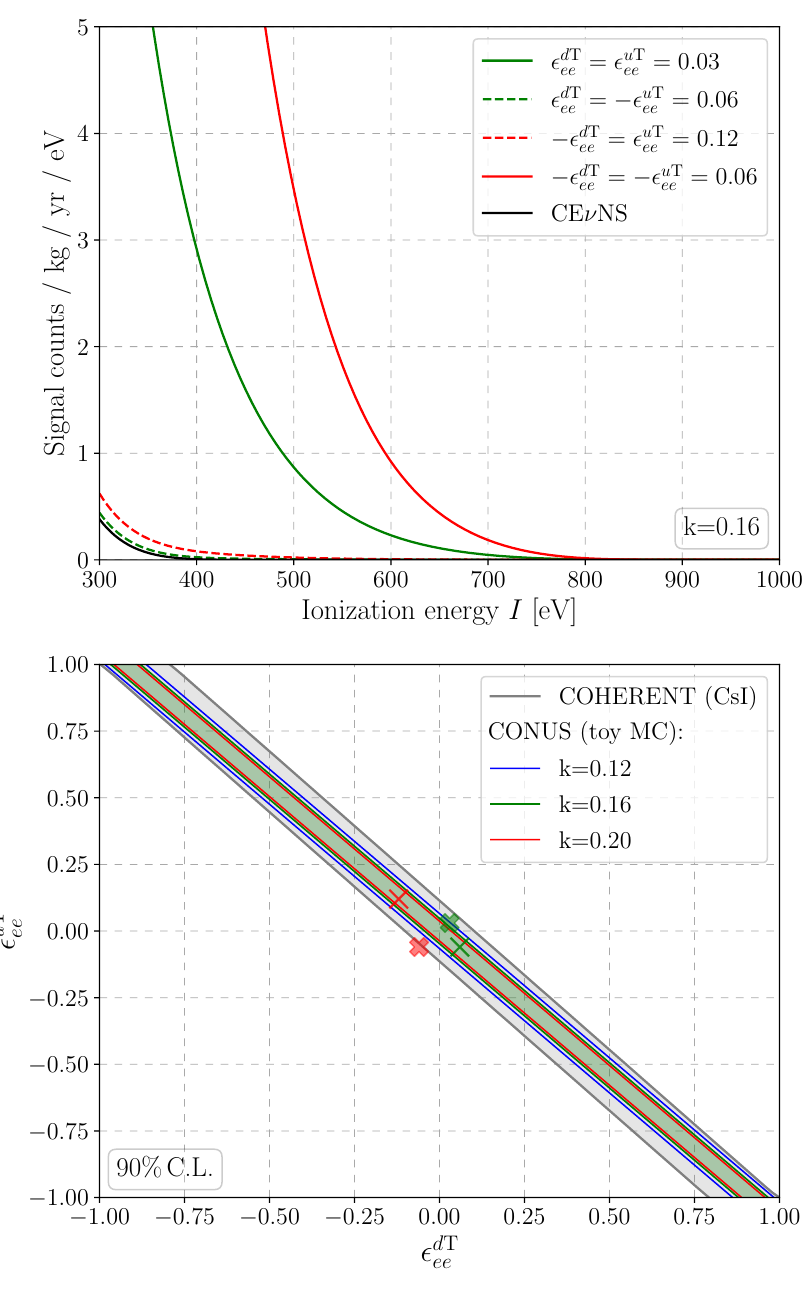
Figure 3 . Top: expected tensor NSI signals of detector C1 for a quenching parameter of k = 0 . 16 and different coupling values from all quadrants in comparison to the standard CE ν NS signal. Due to a different chiral structure, additional tensor NSIs can only enhance the expected signal. Bottom: allowed regions (at 90% C.L.) of tensor NSI couplings (cid:15) u T and (cid:15) d T deduced from the Run -1 Conus ee ee data set. The exemplary points of the upper plot are marked with crosses, where bold crosses indicate couplings that are (almost) excluded, i.e. the solid lines from above. Normal crosses refer to coupling combinations that cannot be excluded with the current data set, i.e. the dashed lines. In addition, constraints (90% C.L.) obtained from Coherent data are plotted for comparison, cf. ref.